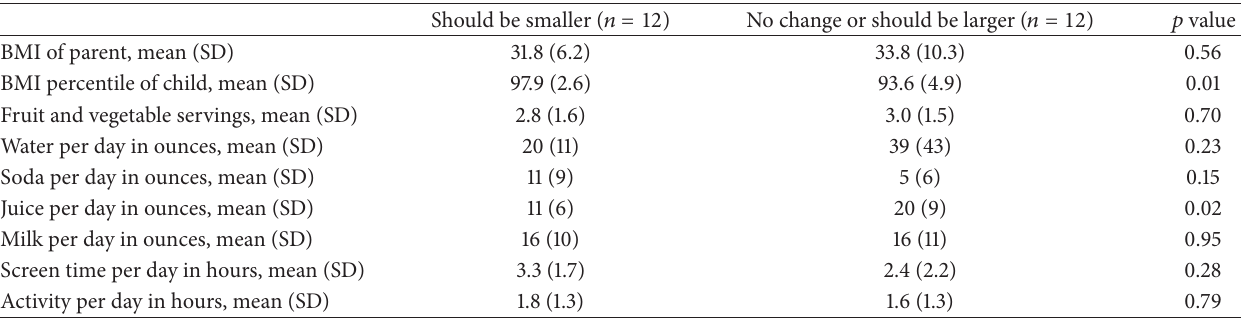
Table 2: Health practices among overweight and obese subjects grouped by their parents’ comparison of their ideal weight compared to their current